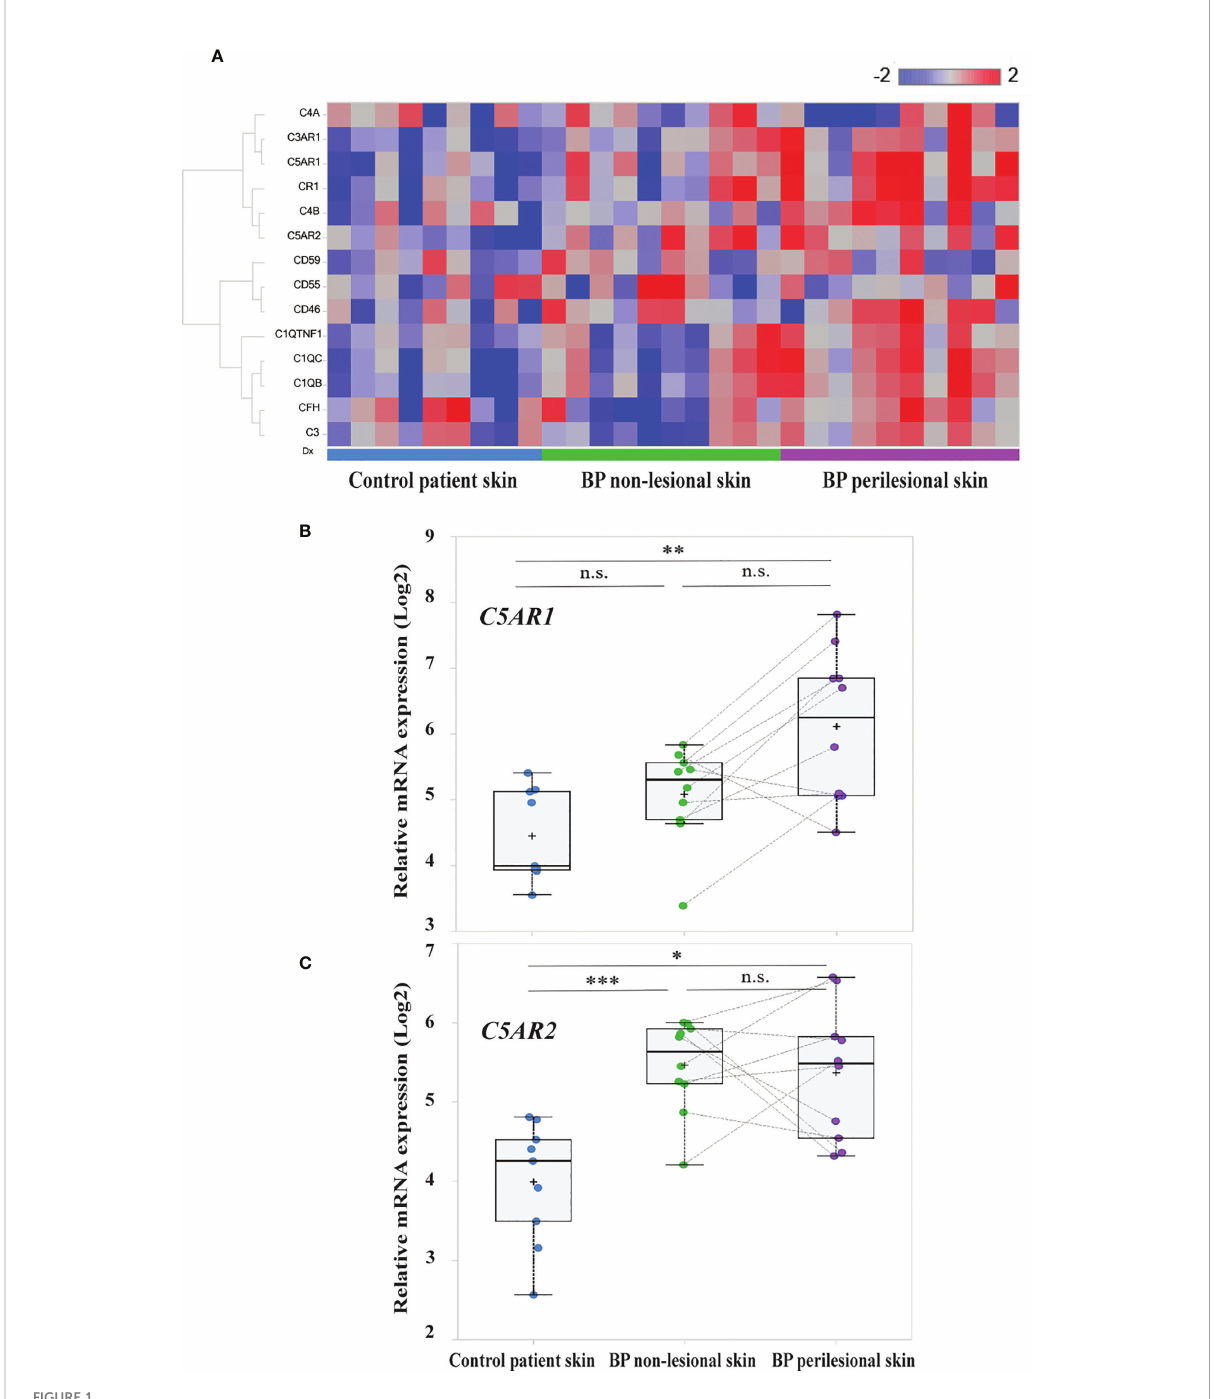
FIGURE 1 Transcriptome analysis identi fi ed C5AR1 and C5AR2 to be highly upregulated in early bullous pemphigoid (BP) skin lesions. (A) Heatmap of the complement and complement-related genes. RNA sequencing was performed on perilesional and site-matched non-lesional skin biopsies from BP patients (n=10) as well as site-matched biopsies from age- and sex-matched control subjects (n=9). Blue-red color bar: blue represents low gene expression and red high gene expression. (B, C) Box plots indicate the distribution of the relative mRNA expression levels of C5AR1 (B) and C5AR2 (C) in perilesional (purple) and site-matched non-lesional skin biopsies (green) from BP patients compared to the controls (blue). Plots were based on normalized and log2 transformed FPKM values and the identi fi cation of differentially expressed genes was conducted by DESeq2. FPKM, fragments per kilobase of transcript per million mapped reads; FDR, false discovery rate. *, FDR <0.05, **, FDR <0.01; **, FDR <0.001; n.s., not signi fi cant. , ***p ≤